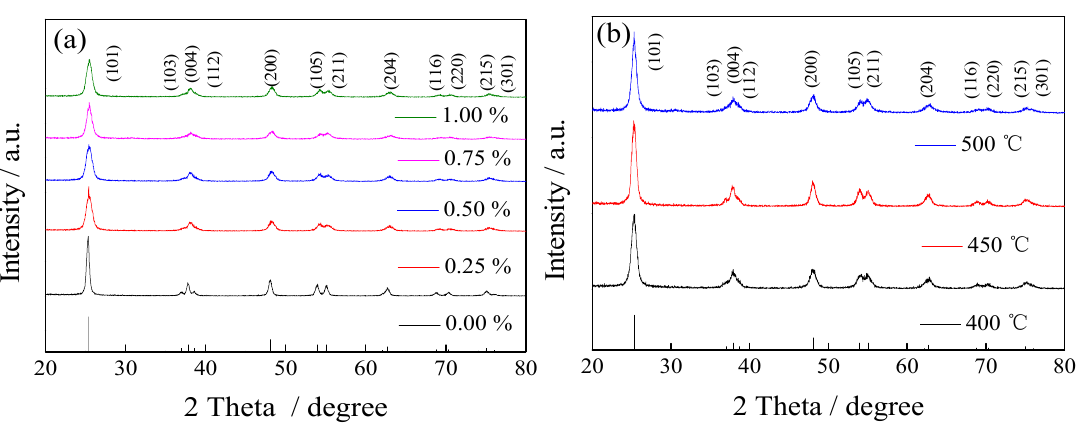
Figure 1. X-ray diffractometer (XRD) patterns of the samples: ( a ) La 3+ with different dopant amounts calcined at 500 °C; ( b ) 0.75% La/TiO 2 at different calcined temperatures.